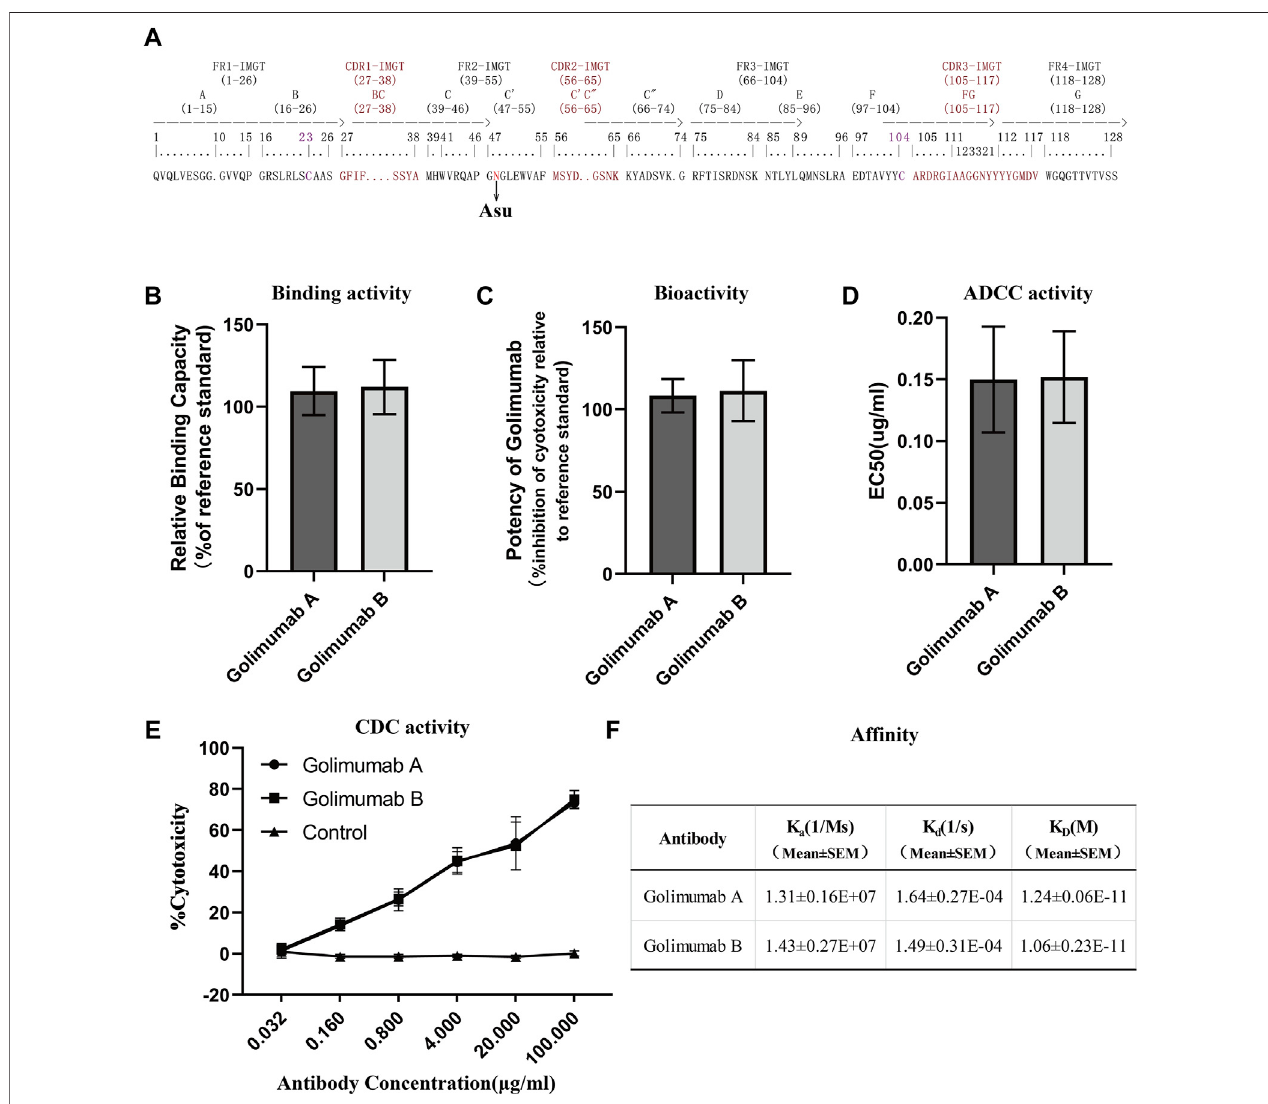
FIGURE 6 | Ef fi cacy evaluation of Asu modi fi cation with a high abundance in golimumab. (A) Three heavy-chain CDRs, FRs, and Asu modi fi cation site of golimumab. Binding (B) and bioactivity (C) , ADCC activity (D) , and CDC (E) activity and af fi nity (F) evaluation of golimumab A and golimumab B.